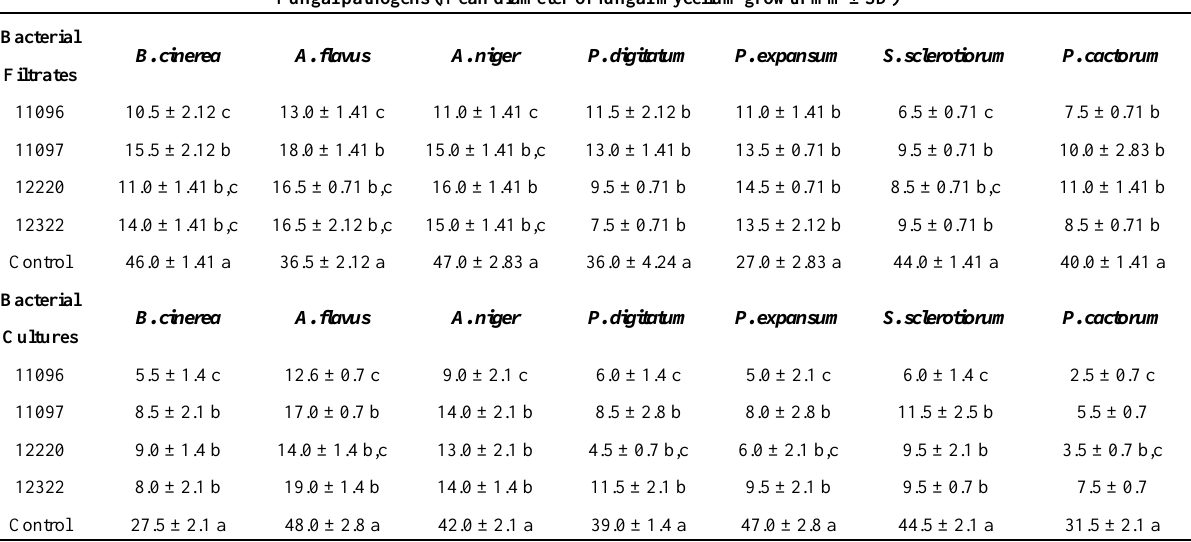
Table 1. In vitro antagonistic activity of bacterial cultures and cell-free culture filtrates recorded as the mean diameter of fungal mycelium growth (mm) ± Standard Deviation. Values followed by the same letter in each vertical column are not significantly different according to Duncan test at p < 0.05. Data were obtained on three